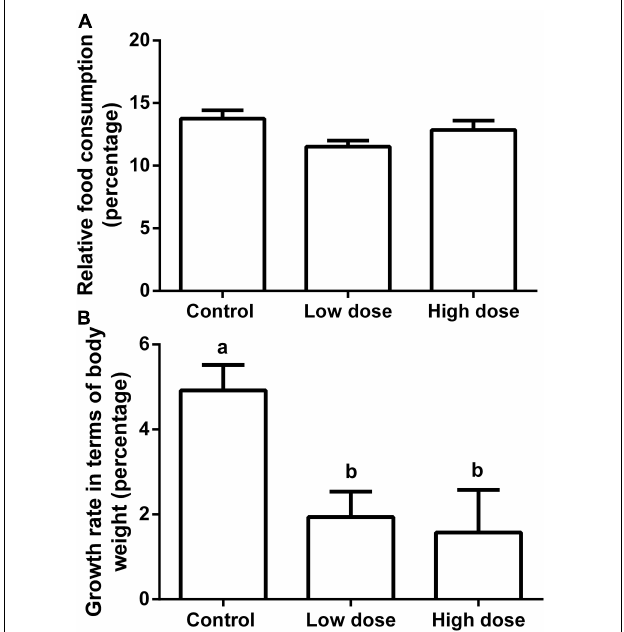
FIGURE 8 | Relative food consumption and growth rate in terms of body weight of adult male Brandt’s vole intragastrically administered a 6-MBOA dose of 0 mg/kg (control group), 1 mg/kg (low dose group), or 2 mg/kg (high dose group). (A) Relative food consumption. (B) Growth rate in terms of body weight. Error bars indicate standard errors. Same letters connect bars with no significant differences at P < 0.05 ( n =